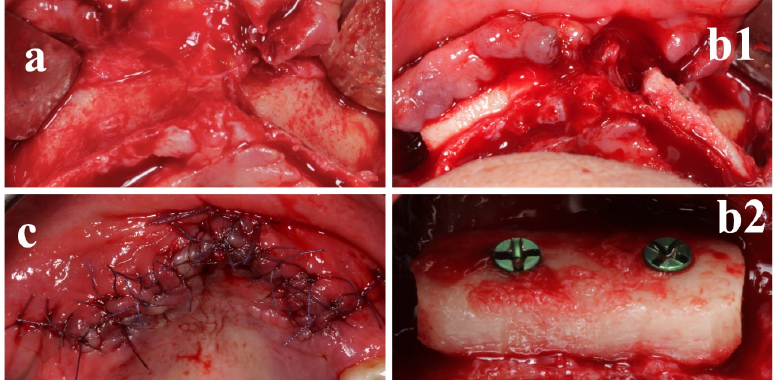
Figure 4. The custom-made freeze-dried bone allograft (FDBA) was positioned in the deficit area and stabilized with a screw. (a) Anatomical site prior surgical procedure and clinical view of the defect. (b1,b2) Screw positioning on a custom-made FDBA. (c) Sutures. ( b1,b2 ) Screw positioning on a custom-made FDBA. ( c )